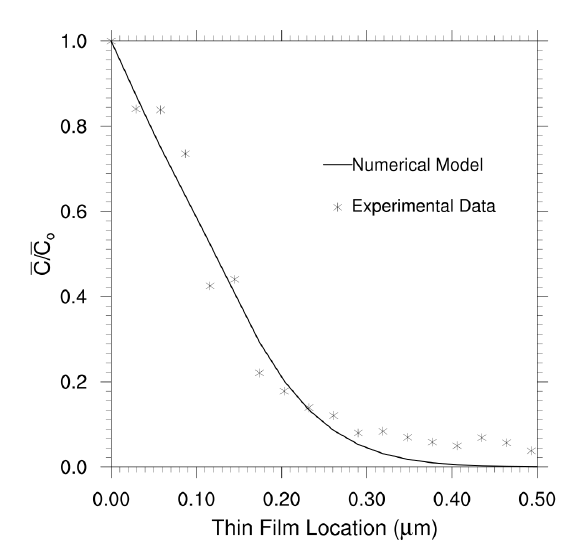
Figure 8. Comparison of the numerical profile and SIMS profile for RT case.